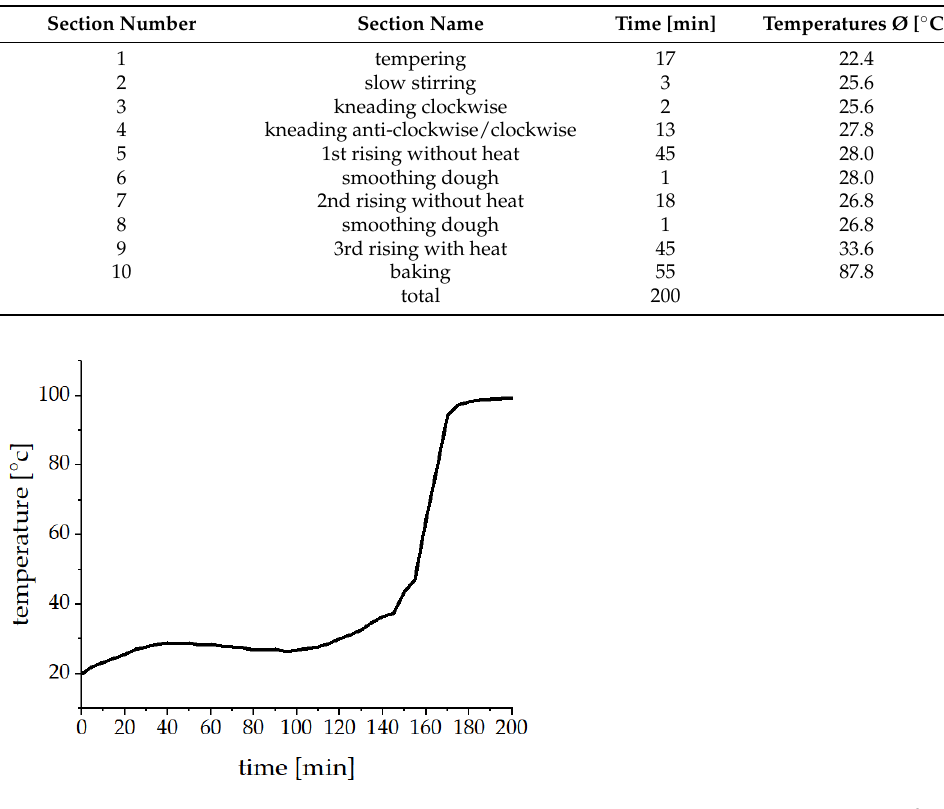
Figure 1. Temperature profile of the rise and baking in the bread maker (UNOLD Backmeister ® extra Modell 65811, UNOLD AG, Hockenheim, Germany). Table 1. Baking program of the UNOLD Backmeister ® extra Modell 65811.